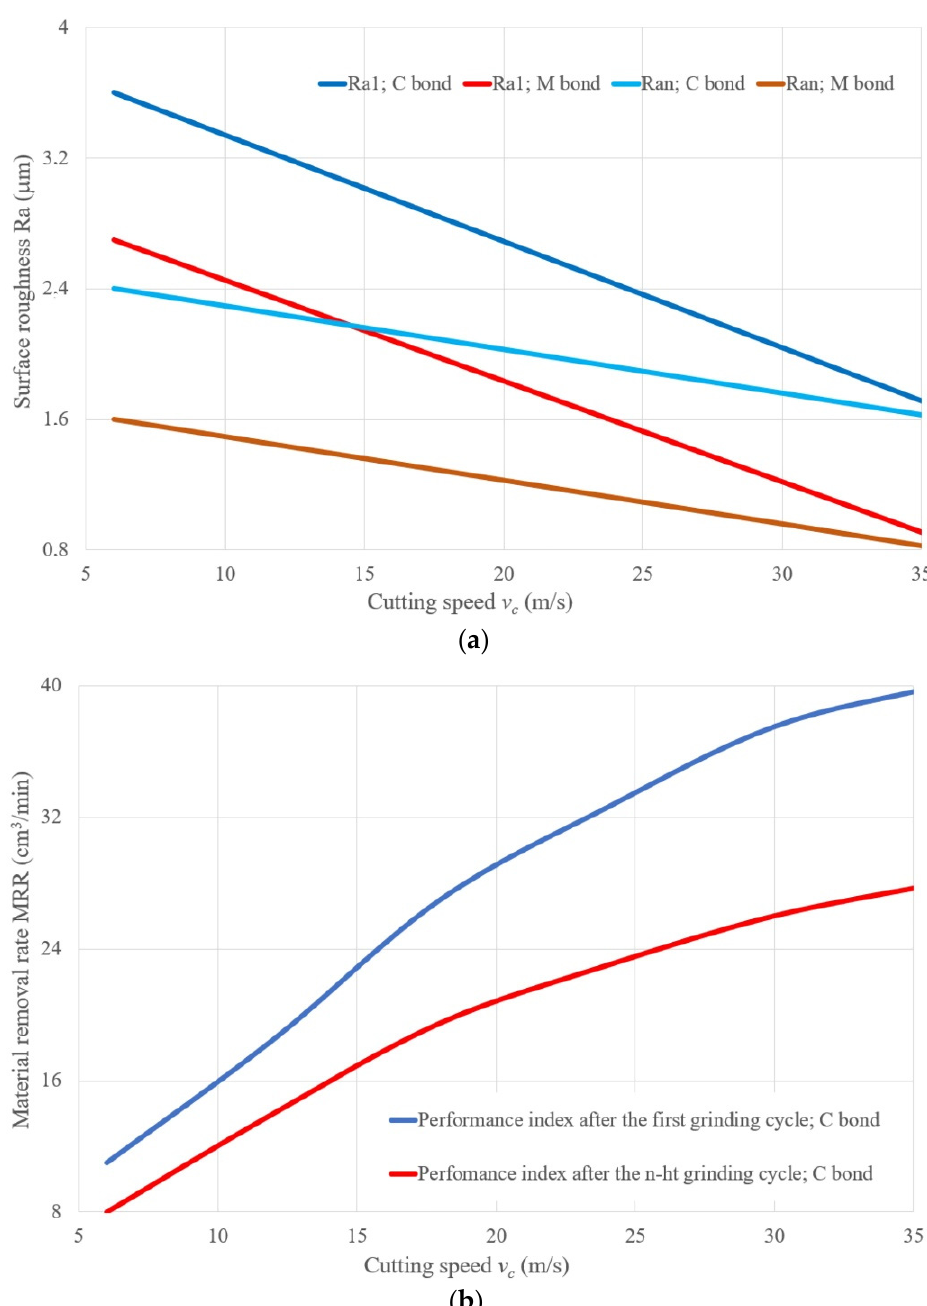
Figure 4. The dependencies of the surface roughness 𝑅𝑎 ( a ) and the material removal rate (MRR)